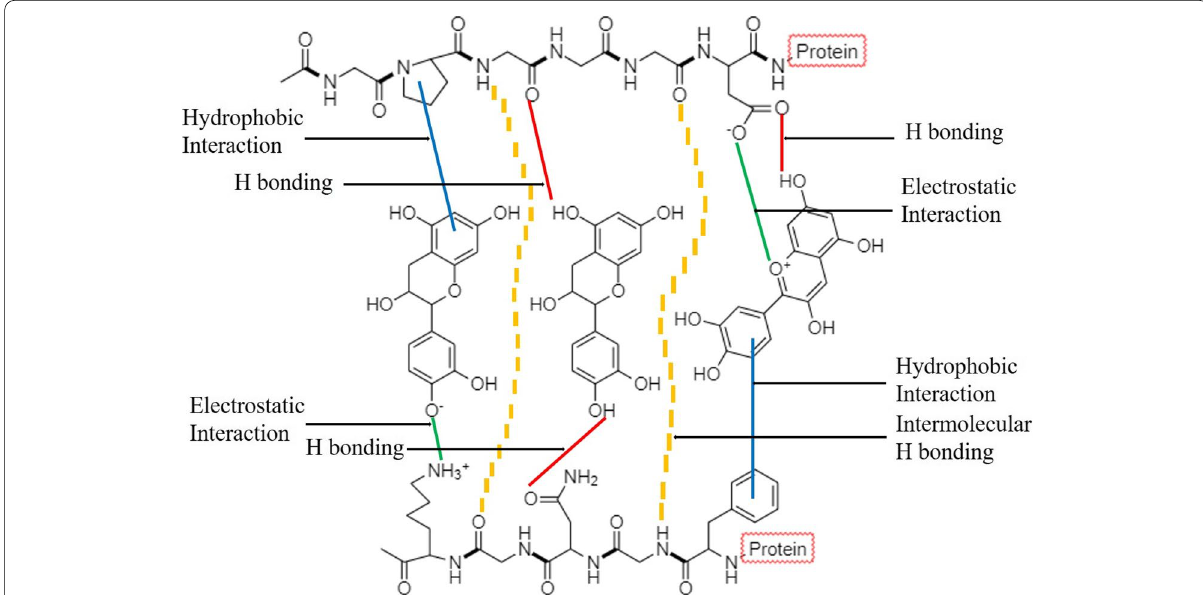
Fig. 7 Major non-covalent interactions between polyphenols and proteins; green, red and blue lines indicate electrostatic interactions, hydrogen bonding and hydrophobic interaction, respectively (Adapted from Le Bourvellec & Renard 2012; Li, He, et al. 2021; Li, Ritzoulis, et al.